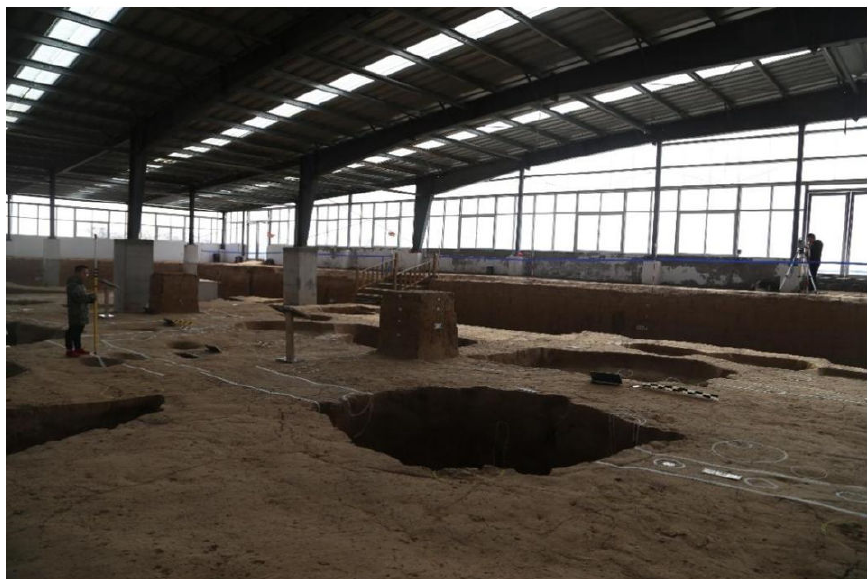
Figure 8. Survey and mapping of the house